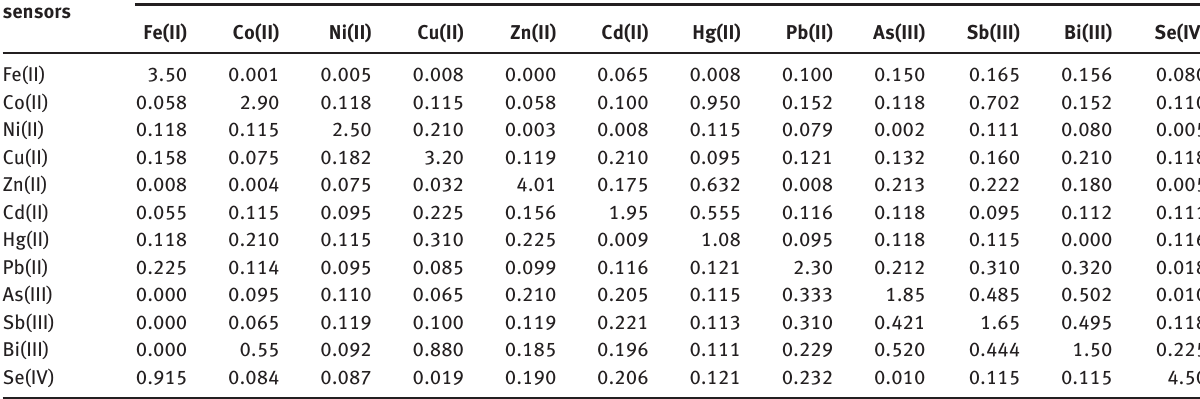
Table 4 Selectivity coefficient K